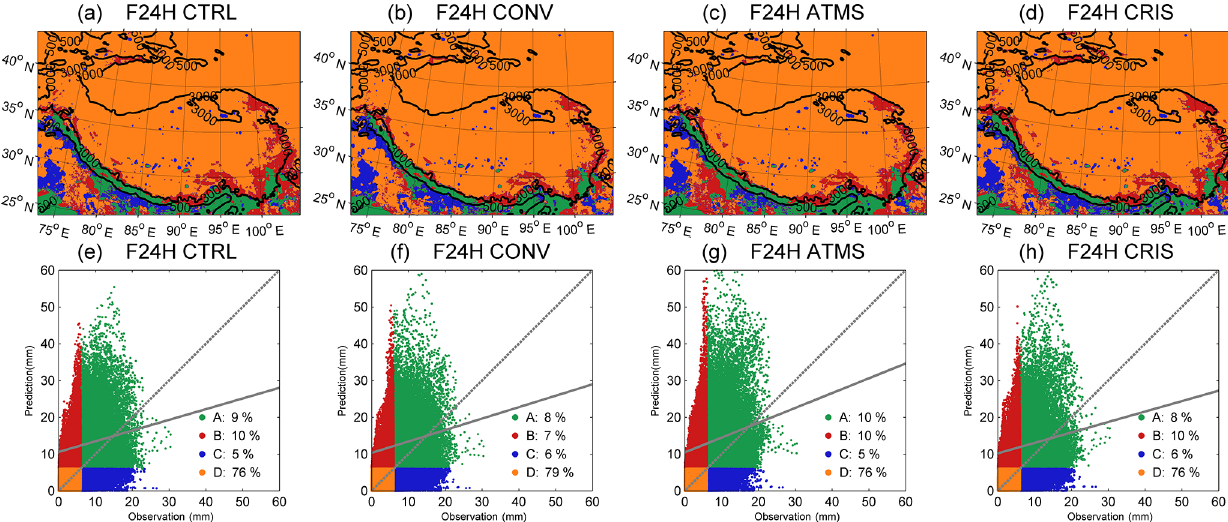
Figure 6. Spatial patterns of (a–d) the contingency table and (e–h) the scatterplots (monthly mean 24h rainfall over 6mmday − 1 threshold is defined as an “event”). A, B, C and D indicate the hits, false alarms, misses, and correct rejections in Table 2, respectively. The solid grey lines indicate the regression line of A. Black contours are altitude (unit: